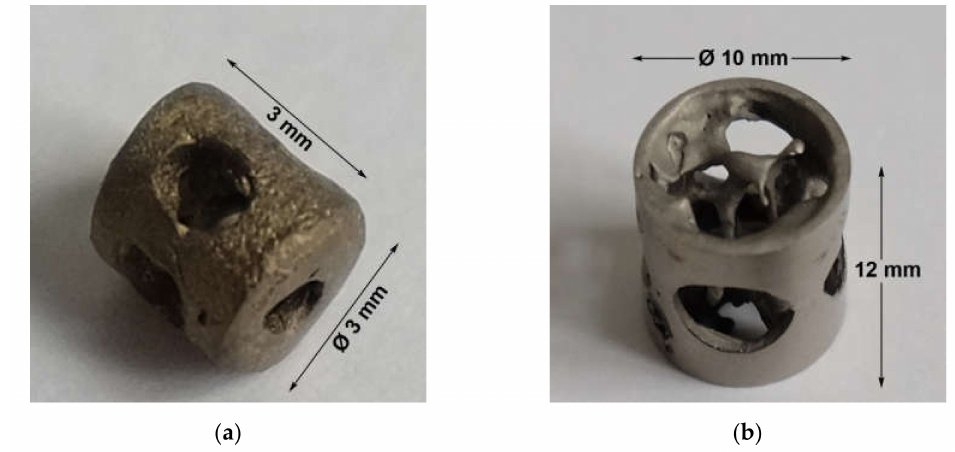
Figure 13. Casted and cleaned implants with and without a calcium titanate reaction layer were used for rats ( a ) and sheep ( b ). The size was 3 mM diameter × 3 mM and 10 mM diameter × 12 mM, respectively. The outer surface of the rat implants shows a macroscopically visible roughness that the sheep implants lack. These were mechanically milled due to geometric reasons.